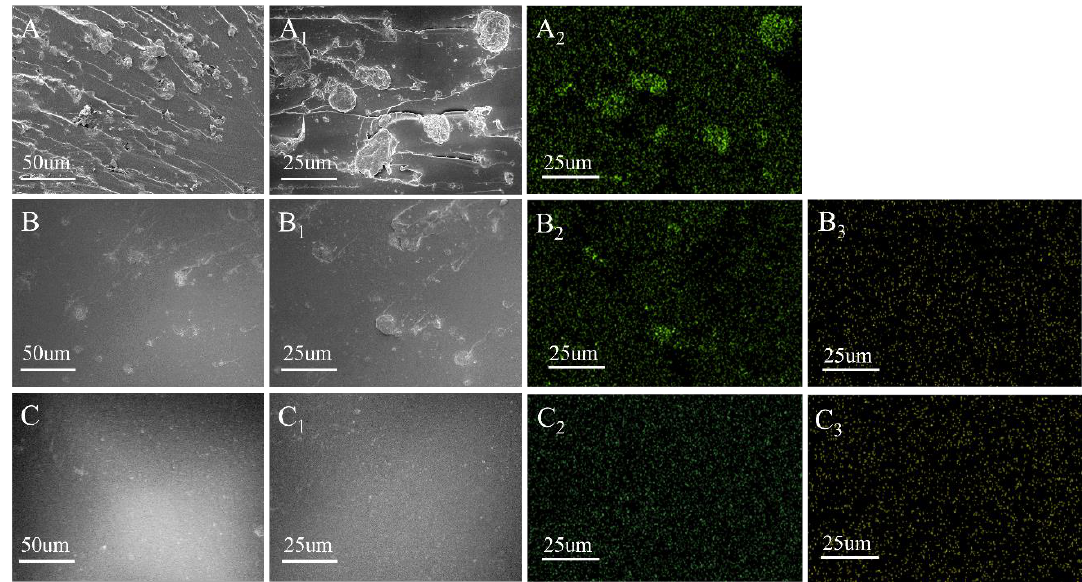
Figure 3. SEM diagram of EPs. ( A , A 1 ) EP/MMT; ( B , B 1 ) EP/DOPO+MMT; ( C , C 1 ) EP/DOPO-MMT; ( A 2 , B 2 , C 2 )Si distribu- tion mapping; ( B 3 , C 3 )P distribution mapping.